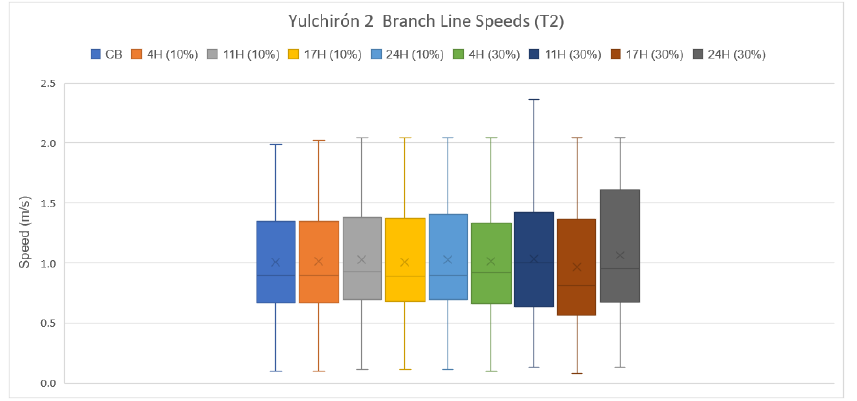
Figure 18. Yulchirón 2 (T2) branch line speeds operating in shifts, scenario 2. Figure 18. Yulchir ó n 2 (T2) branch line speeds operating in shifts, scenario